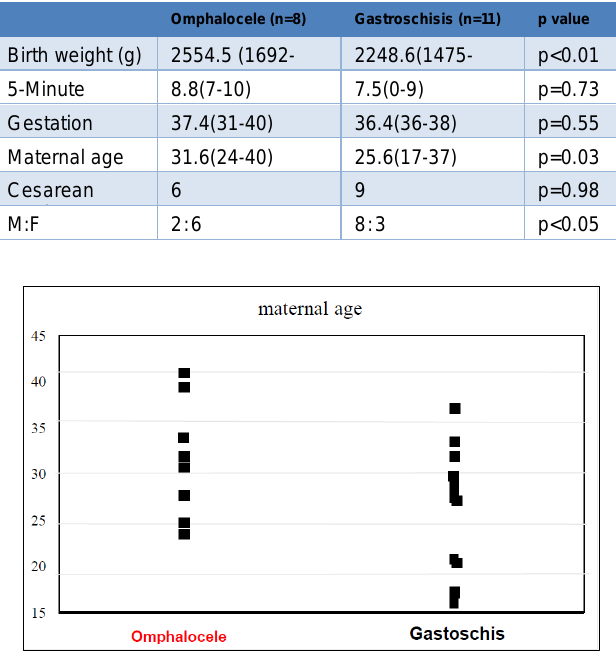
Figure 1: Maternal age in omphalocele and gastroschisis. The average birth weight of the infants with gastroschisis was 2248.6 g (1475 g to 3000 g), including six cases of low birth weight (1500 g to 2499 g) and one case of extremely immature infants (1000 g to 1499g). The average 5-minute Apgar score was 7.5. The average gestation period in weeks was